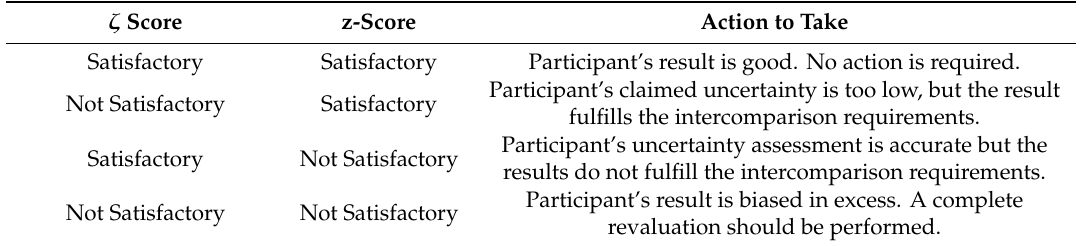
Table 5. Summary of guidelines to understand the Zeta score ( ζ ) and z-score ( z ).